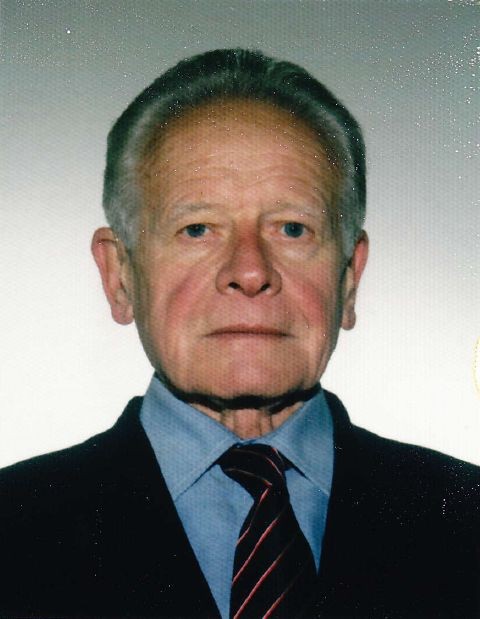
Recent picture (2013).